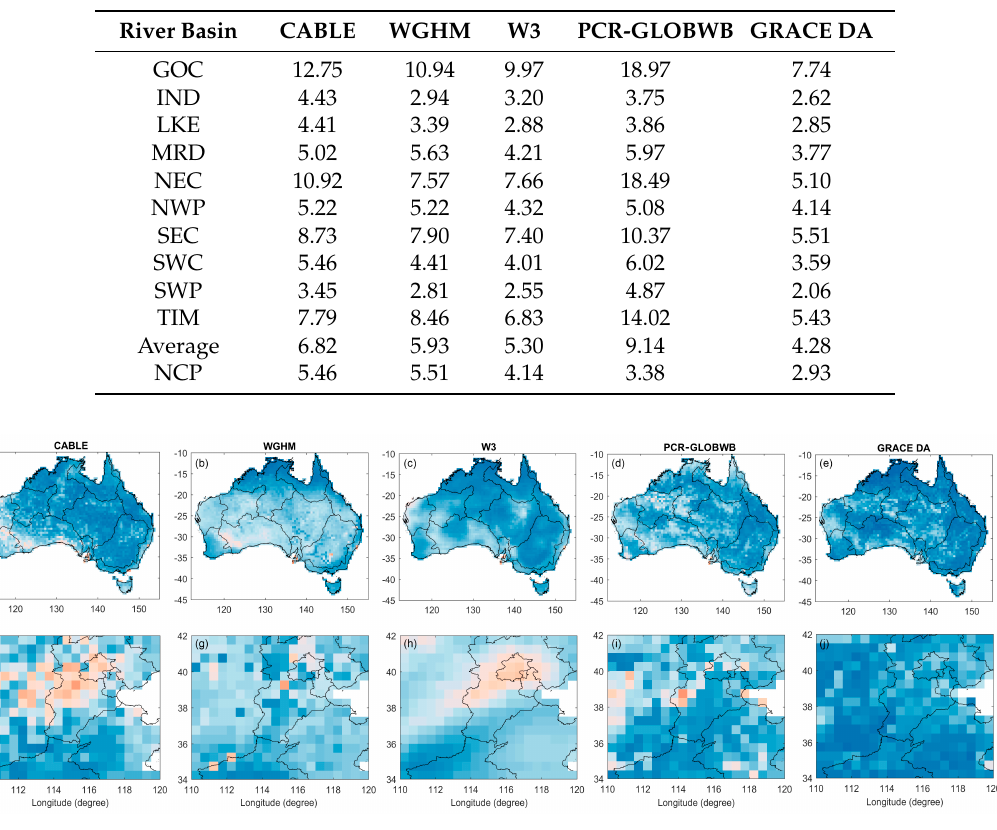
Figure 3. The correlation coefficient between the GRACE observation and Δ TWS estimates from four models (CABLE ( a , f ), WGHM ( b , g ), W3 ( c , h ), PCR-GLOBWB ( d , i )) and GRACE DA ( e , j ) in Australia (top row) and NCP (bottom row).